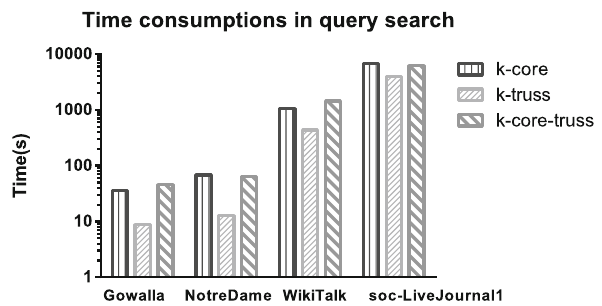
Fig. 7 Running time in query processing of finding k -core, k -truss and k - core - truss for a given node